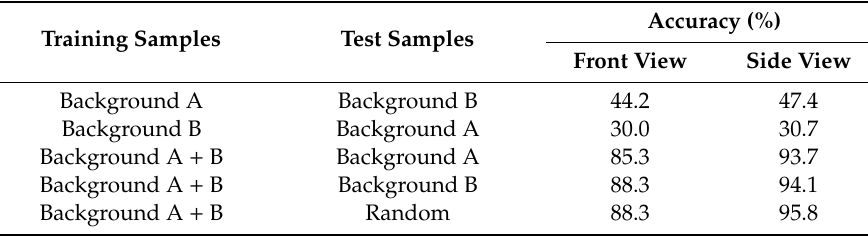
Table 8. Recognition accuracy according to the backgrounds.